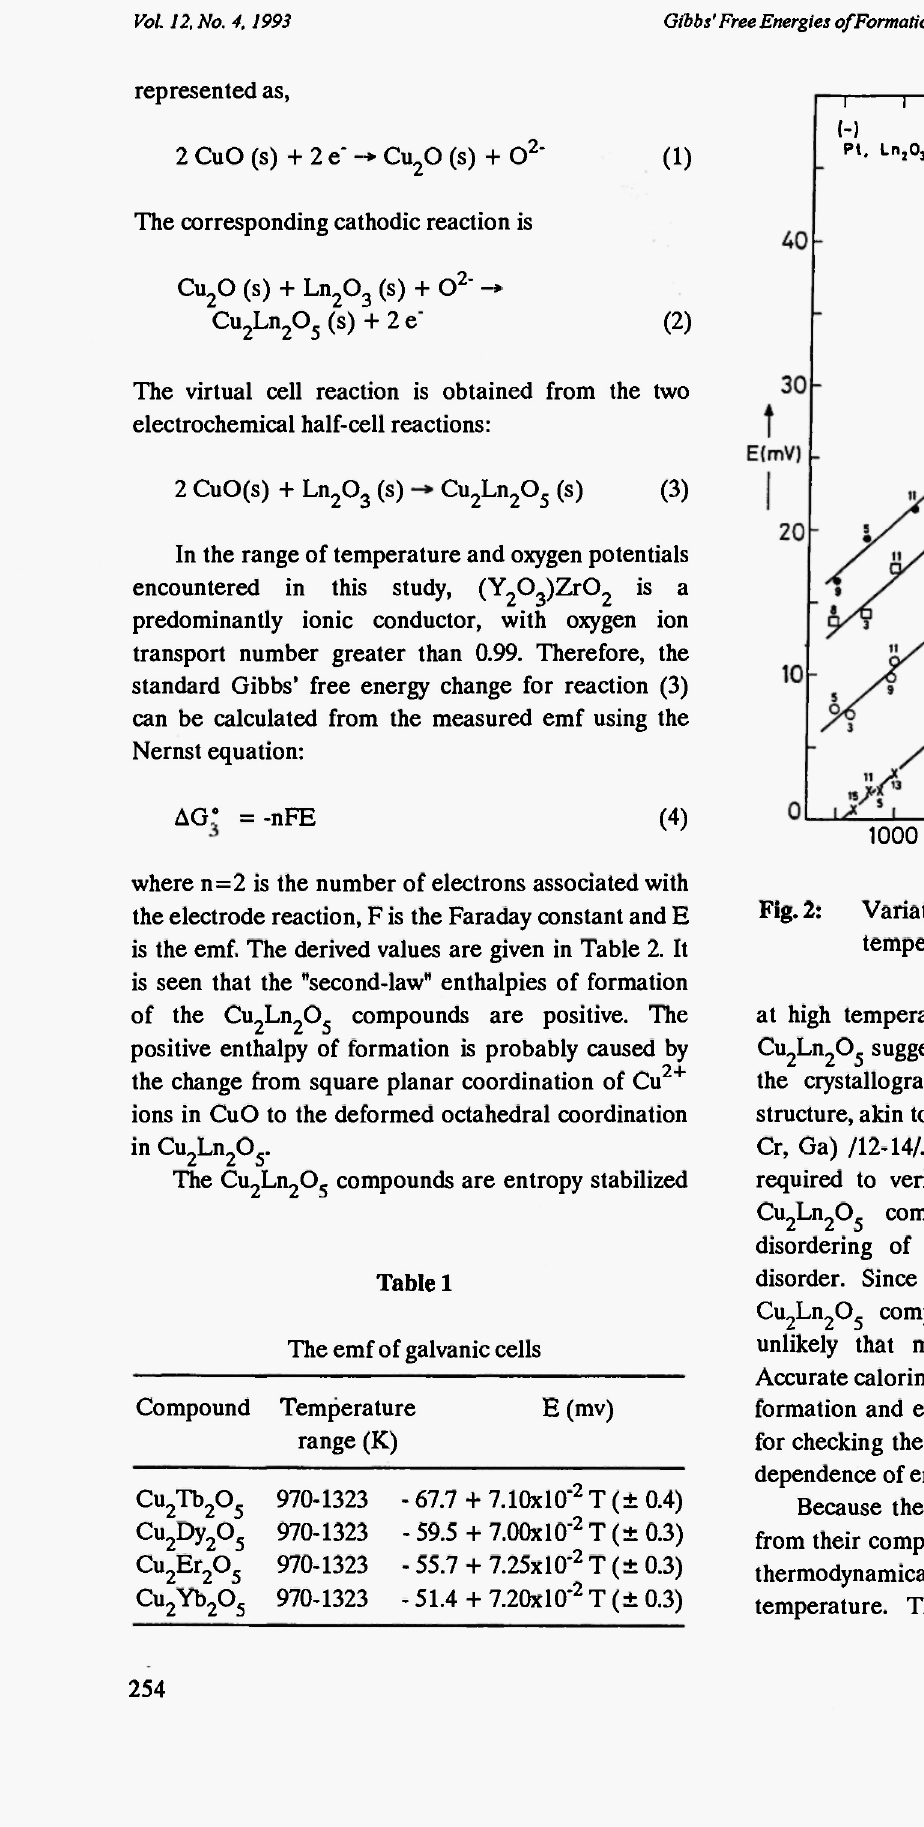
The emf of galvanic cells